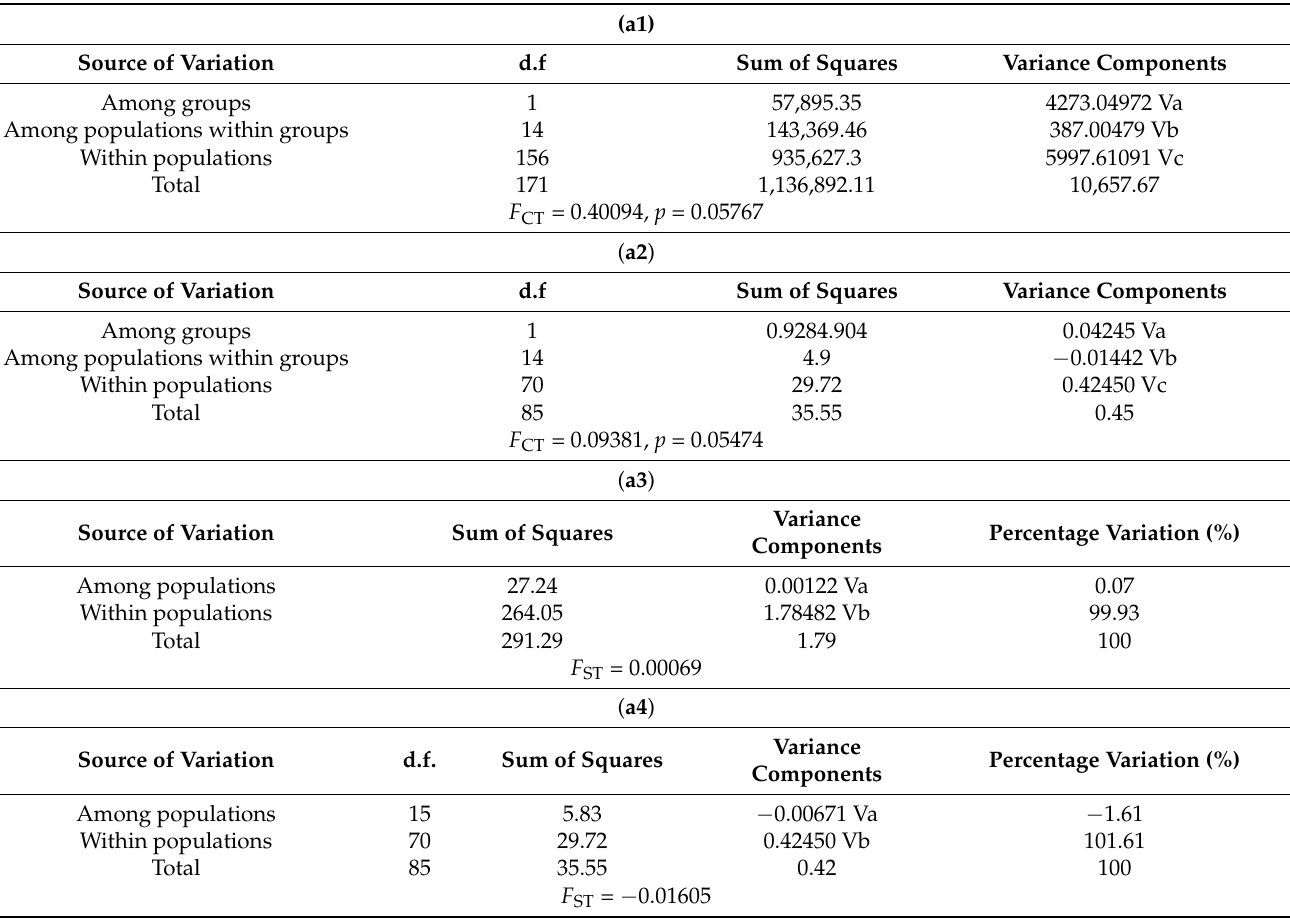
Table 8. ( a1 ). Spatial analysis of molecular variance (SAMOVA) of SSR data and ( a2 ) SAMOVA of mt COI data showing the genetic diversity partitions in the O. mutabilis populations. ( a3 ) and ( a4 ) Analysis of molecular variance (AMOVA) of the genetic structure as suggested by SAMOVA for SSR and mt COI data